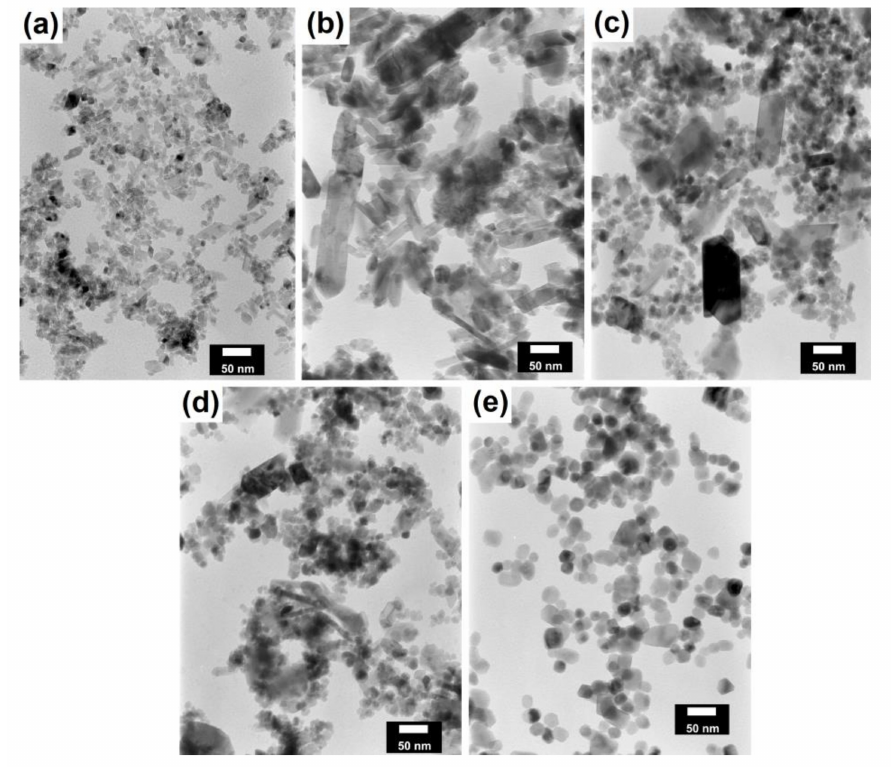
Figure 1. TEM images for composite materials and reference samples: ( a ) TiO 2 ; ( b ) (7)TiO 2 –(3)Fe 3 O 4 ; ( c ) (5)TiO 2 –(5)Fe 3 O 4 ; ( d ) (3)TiO 2 –(7)Fe 3 O 4 ; ( e ) Fe 3 O